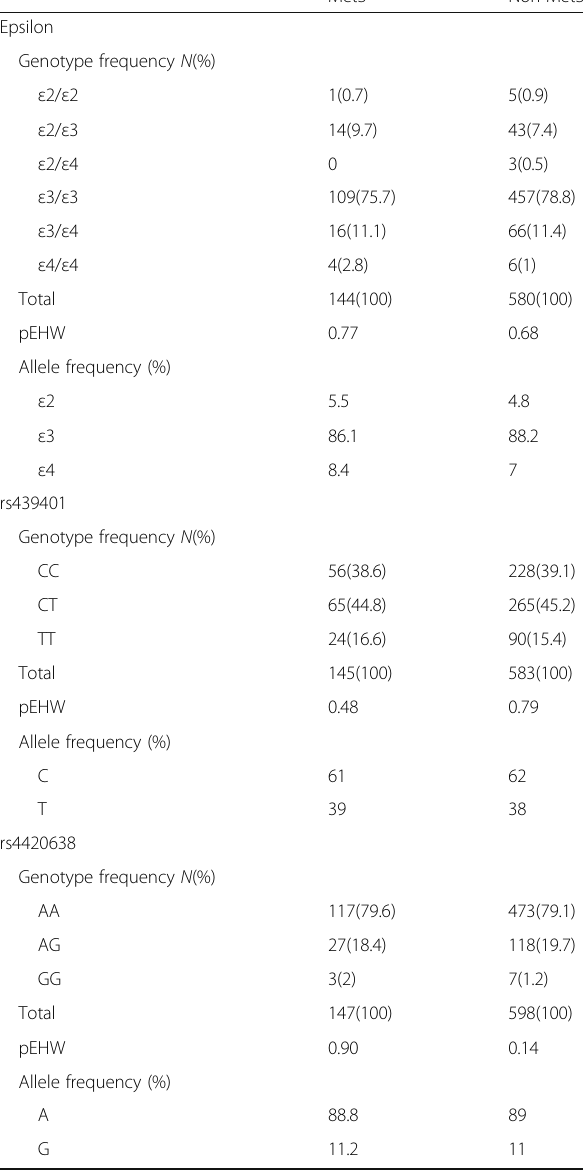
Table 2 Genotype and allele frequencies of APOE ε , rs439401, Table 4 APOE epsilon polymorphism and cardiometabolic and rs4420638 in case and control groups MetS Non-MetS